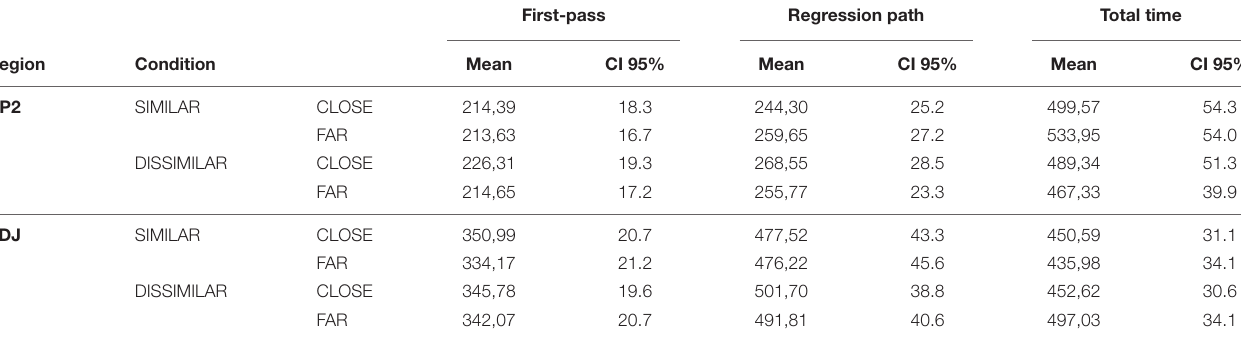
TABLE 1 | Mean reading times in milliseconds and within-subject adjusted 95% confidence intervals (by condition, region and measure) in Experiment 1. First-pass Regression